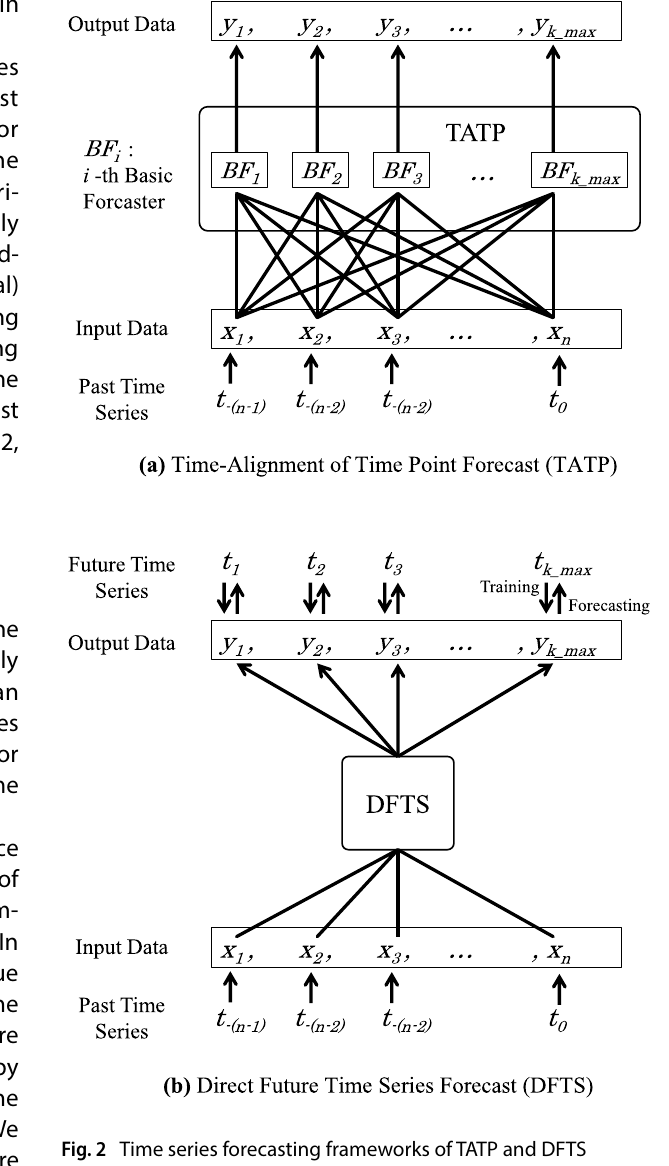
Fig. 2 Time series forecasting frameworks of TATP and